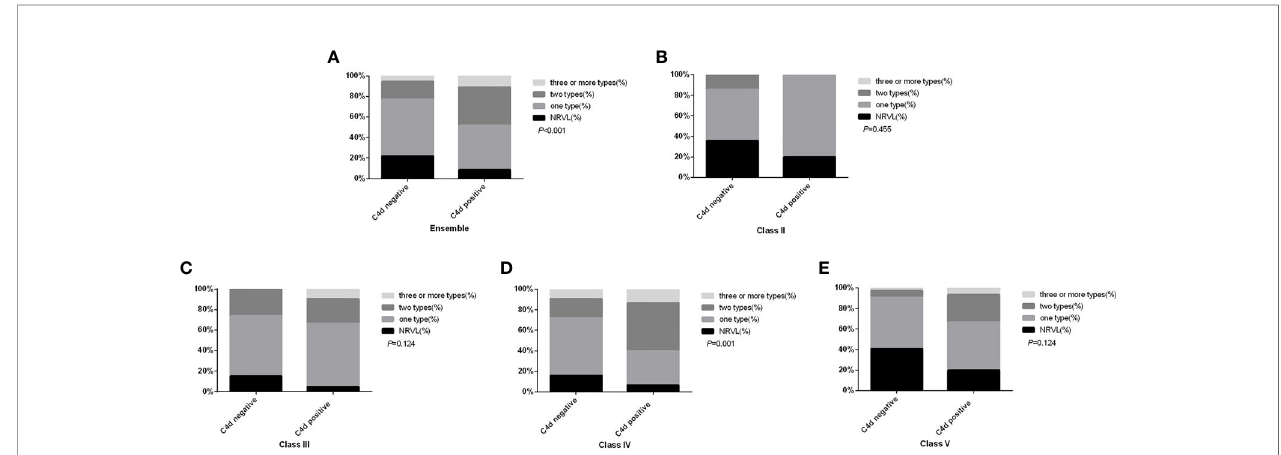
FIGURE 3 | Comparison of renal microvascular lesion types between patients with and without arteriolar C4d deposition in the ensemble (A) , in subgroup class II (B) , in subgroup class III (C) , in subgroup class IV (D) , and in subgroup class V (E) . NRVL, no renal microvascular